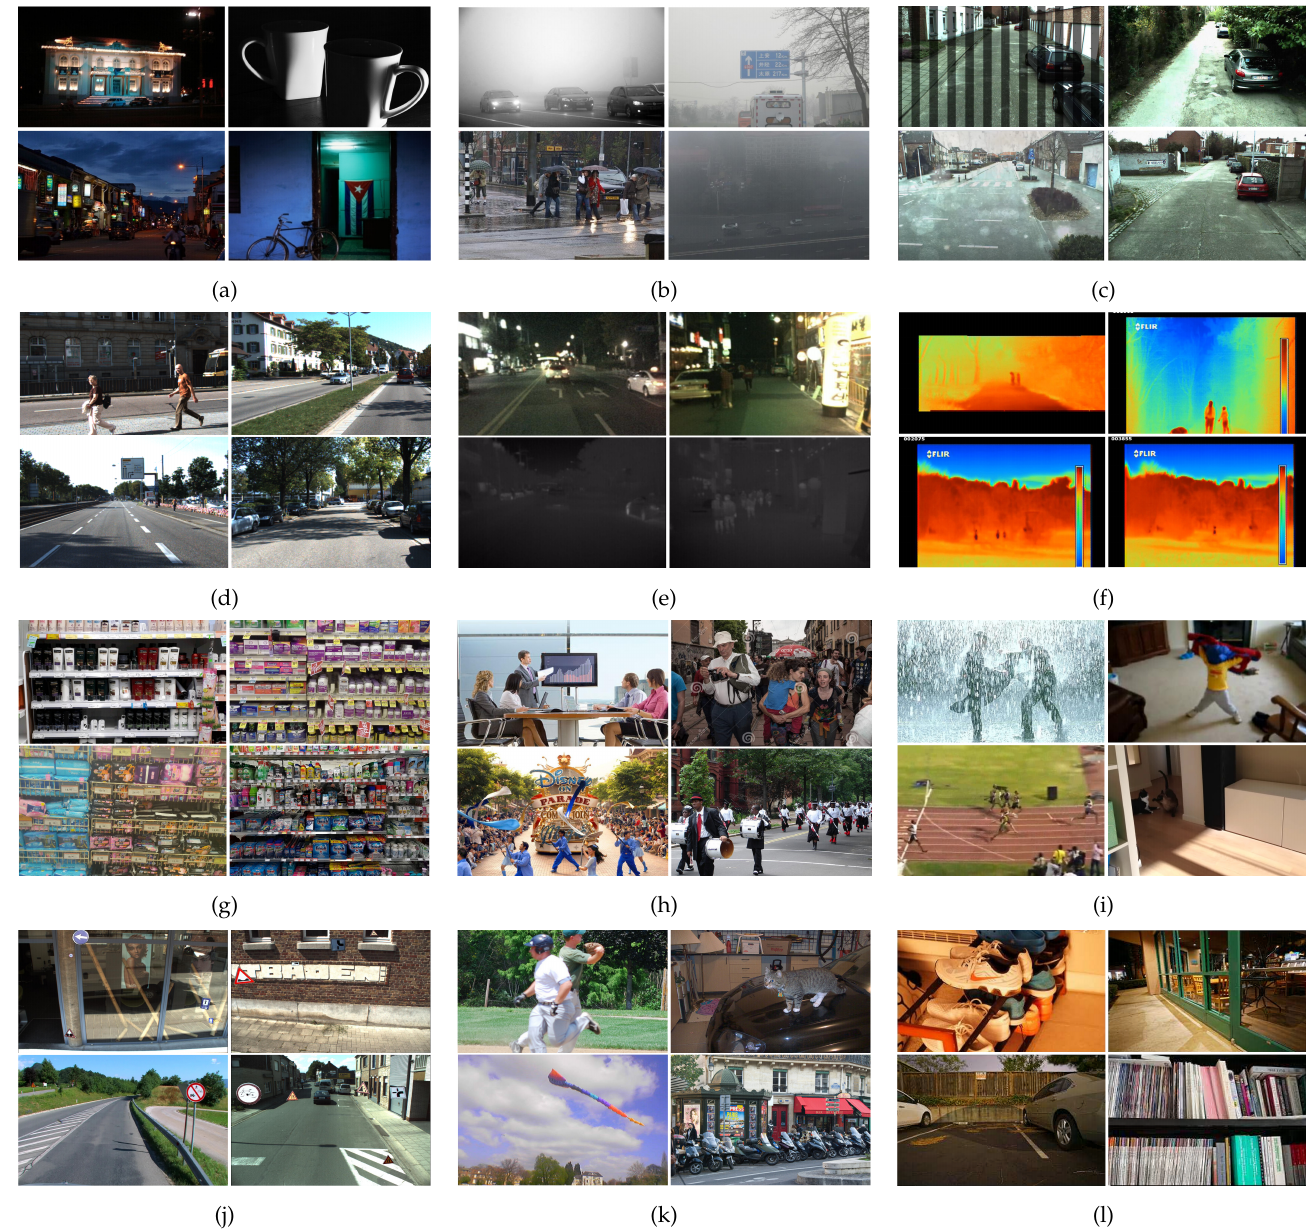
Figure 15. Sample images belonging to challenging datasets. ( a ) Represents samples taken from ExDark [97] showing low- light examples, ( b ) depicts samples from Reside [98] explaining harsh weather, ( c ) describes samples from CURE-TSD [92] illustrating example of camera distortion, lens flare, ( d ) denotes samples from KITTI [89] depicting various objects to be detected, ( e ) represents samples from Kaist [59] explaining saliency maps with their night-time images, ( f ) depicts samples taken from UNIRI-TID [55] showing example of thermal images, ( g ) highlights samples from SKU-110K [63] representing example of cluttered objects, ( h ) represents samples taken from Wider Face [72] showing faces at various angles, ( i ) represents samples taken from VOT-2018 [95] presenting example of complex indoor scenes, ( j ) shows samples taken from DFG [82] illustrating traffic signs at various places, ( k ) represents images taken from MS-COCO [12] describing example of objects in daily life and ( l ) outlines samples taken from see in the dark [53] dataset exhibiting examples captured at low illumination and high